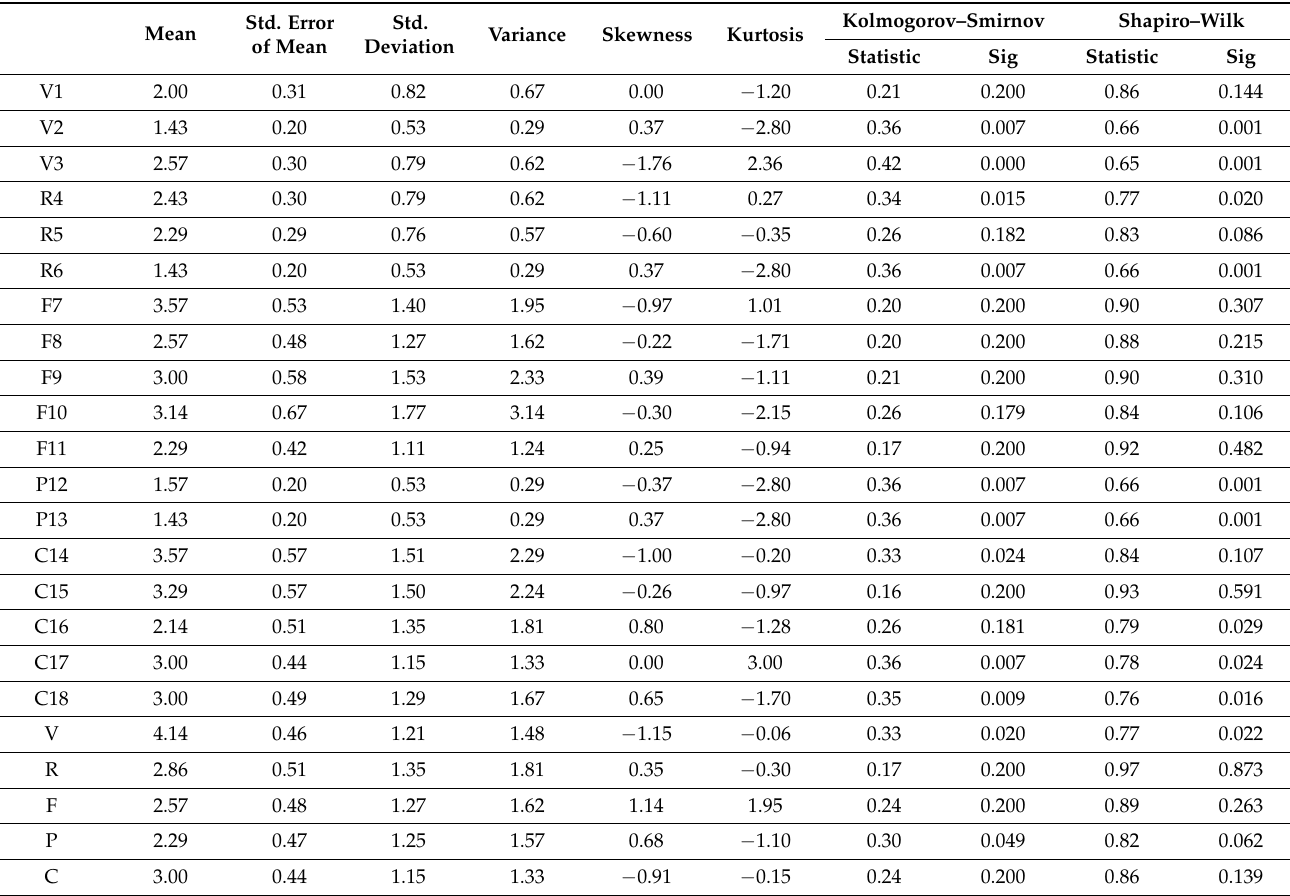
Table 3. Summary of statistical analysis results for driver